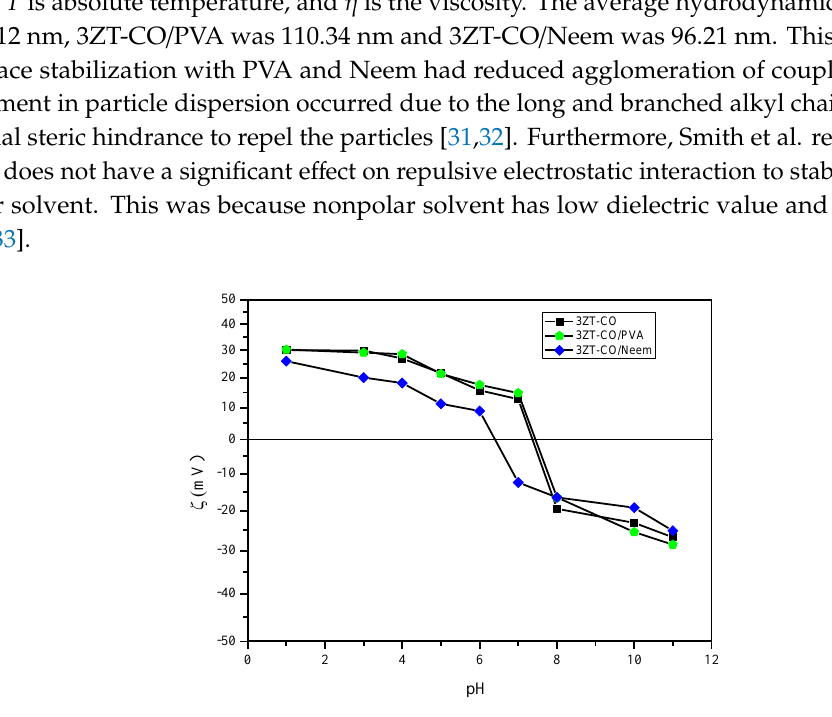
Figure 6. The graph of zeta potential versus pH of (a) non-functionalized 3ZT-CO, (b) stabilized 3ZT-CO/PVA, and (c) 3ZT-CO/Neem at different pH values.